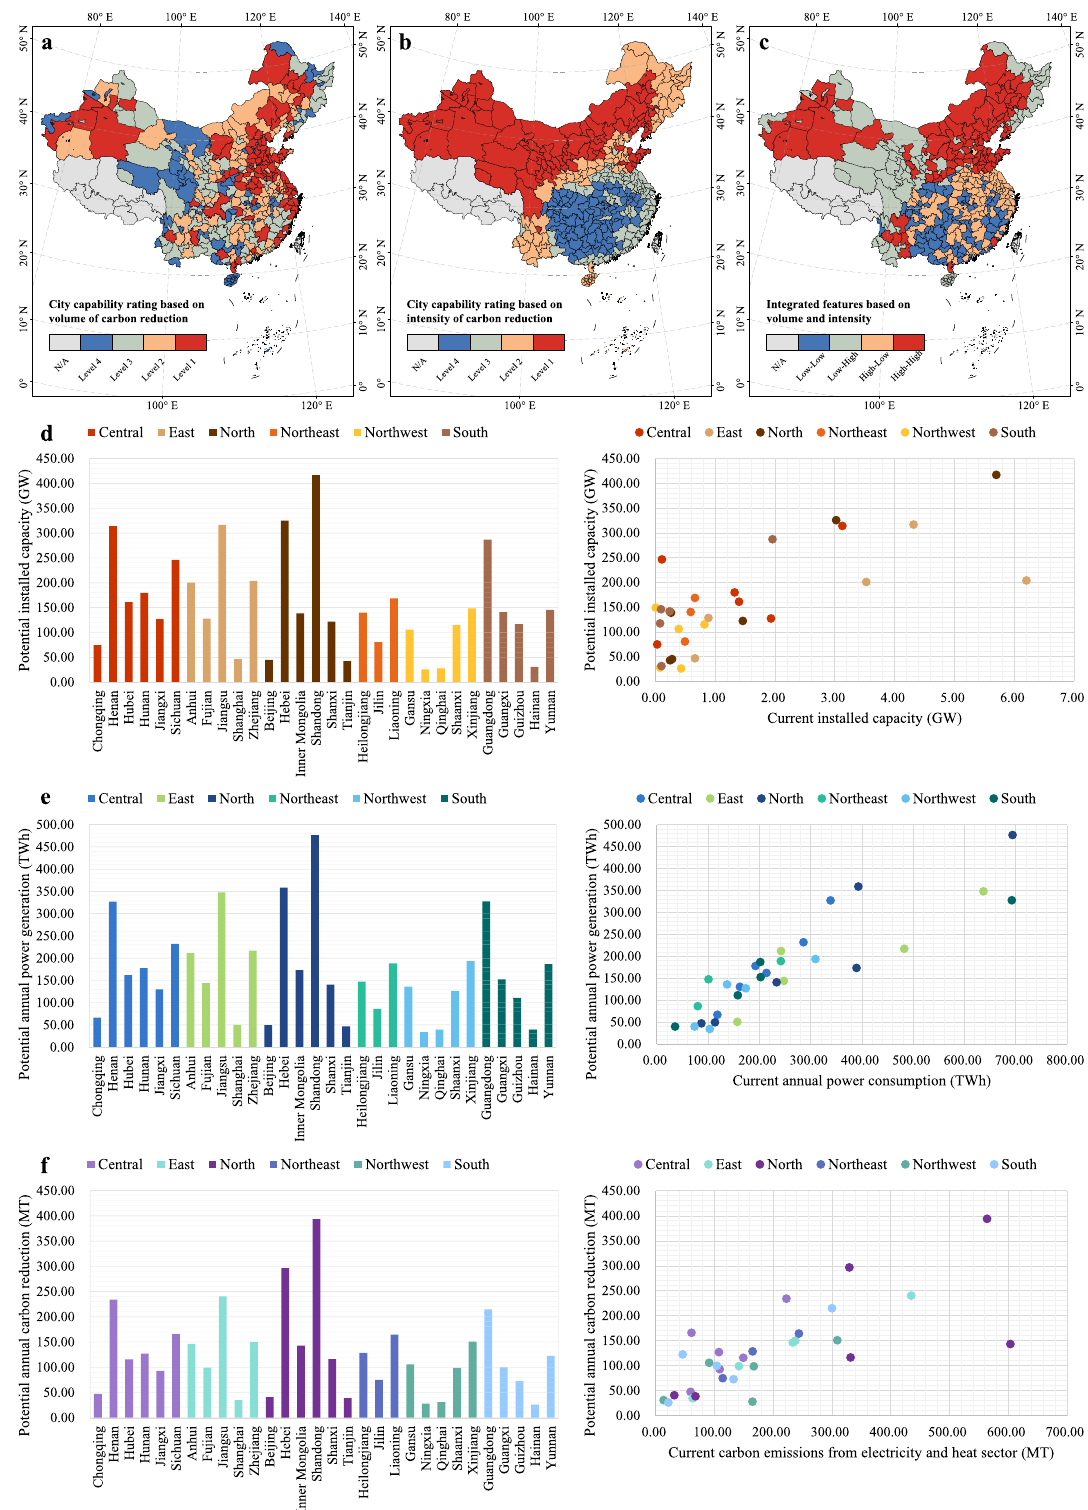
Fig. 6 | Regional analysis for the sustainable development of RPVs. a City cap- abilityratingbasedonthevolumeofRPVcarbonmitigation. b Citycapabilityrating basedontheintensityofRPVcarbonmitigation.Levels1 to4representdecreasing capability. c Integratedfeaturesofcarbonmitigationvolumeandintensity,withthe High-High pattern representing the city in the top 50% for both indicators.